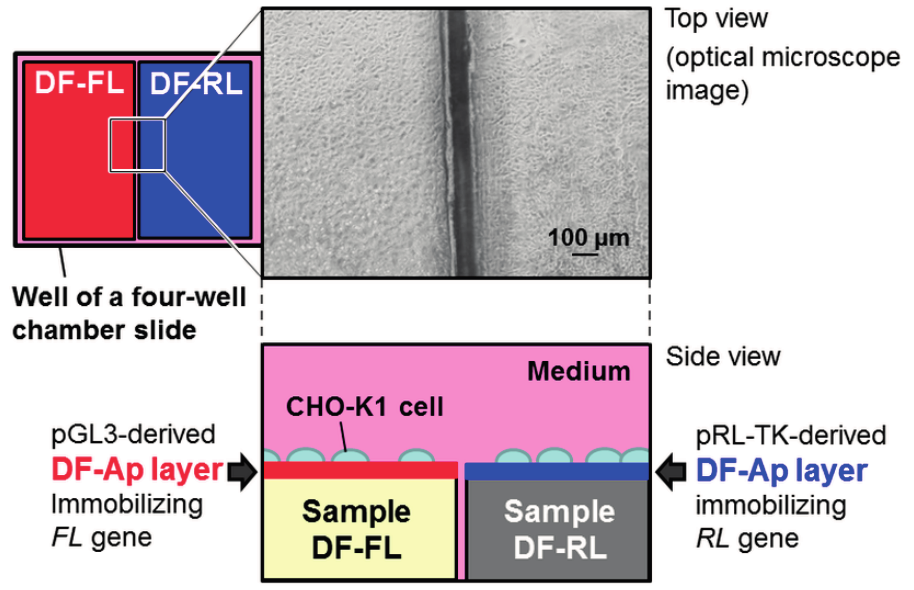
Figure 1. Schematic depiction of the sample setting used in the dual reporter gene transfer